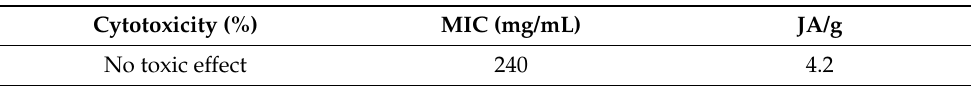
Table 7. Bioactivity, e.g., antibiotic units (JA), minimal inhibitory concentration (MIC), and cytotox- icity of hemp fabric.